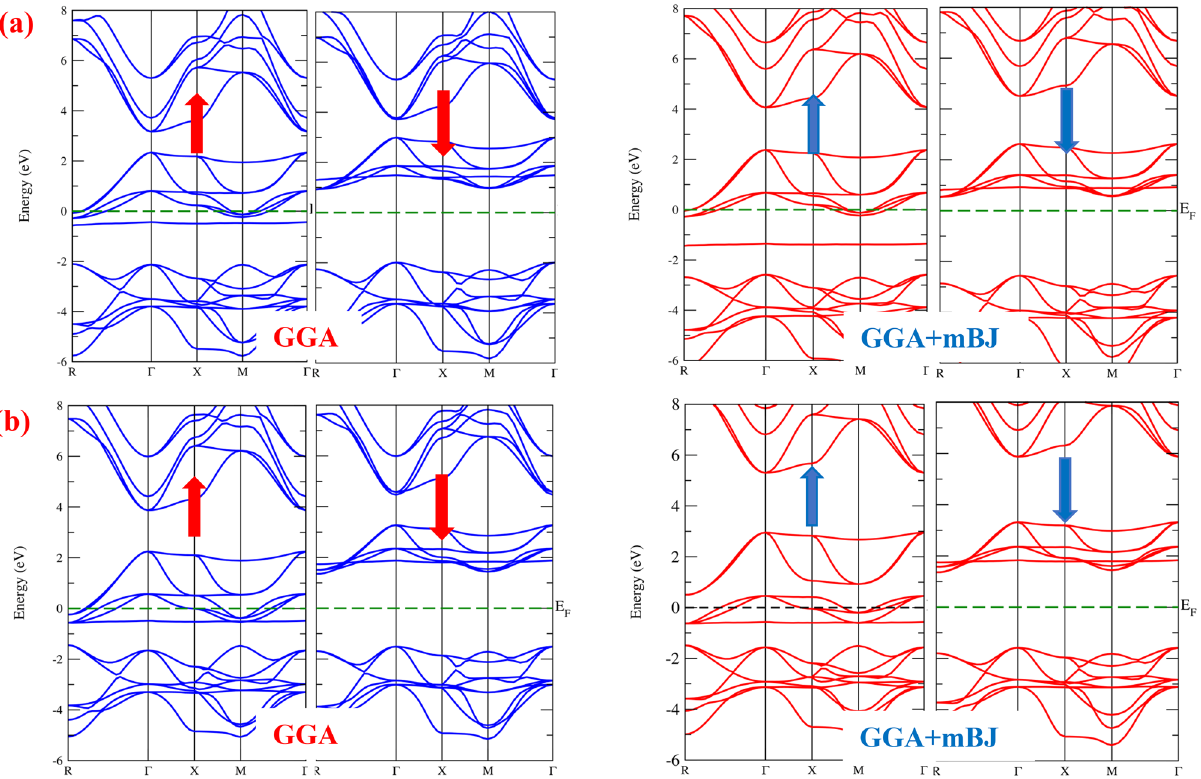
Figure 3. Spin polarised electronic band structure of cubic ( a ) RbNpO 3 and ( b ) RbPuO 3 reckoned by PBE- GGA and GGA + mBJ approximations.